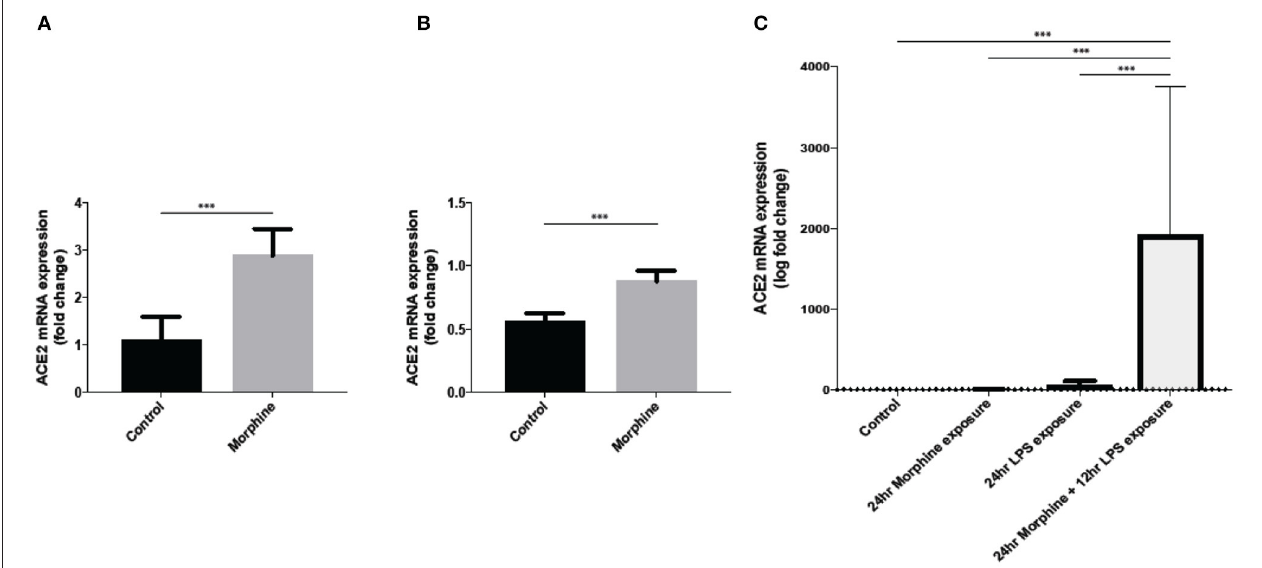
FIGURE 2 | Morphine treatment significantly upregulate ACE2 gene expression in (A) mice lung tissue, (B) mice brain tissue at 24 h post morphine treatment subcutaneously ( n = 5), and (C) ACE2 expression in SIMA9 cells along with LPS treatment ( n = 8–10). Data were analyzed by student’s t -test and one-way ANOVA with post-hoc Tukey’s test. *** P ≤ 0.001. Mean ±